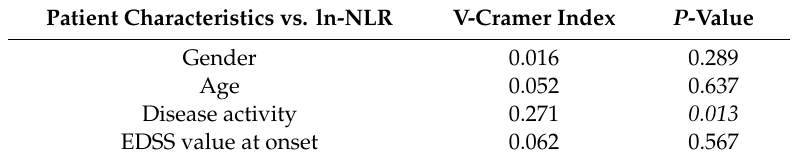
Table 3. Logistic regression model for disease activity at onset.